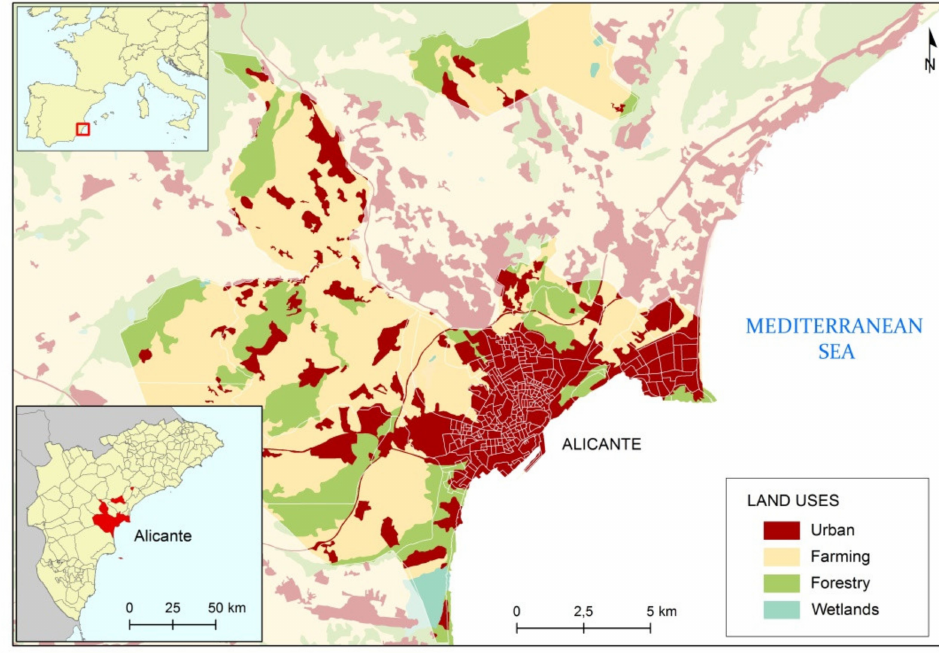
Figure 1. Study area (city of Alicante). Own